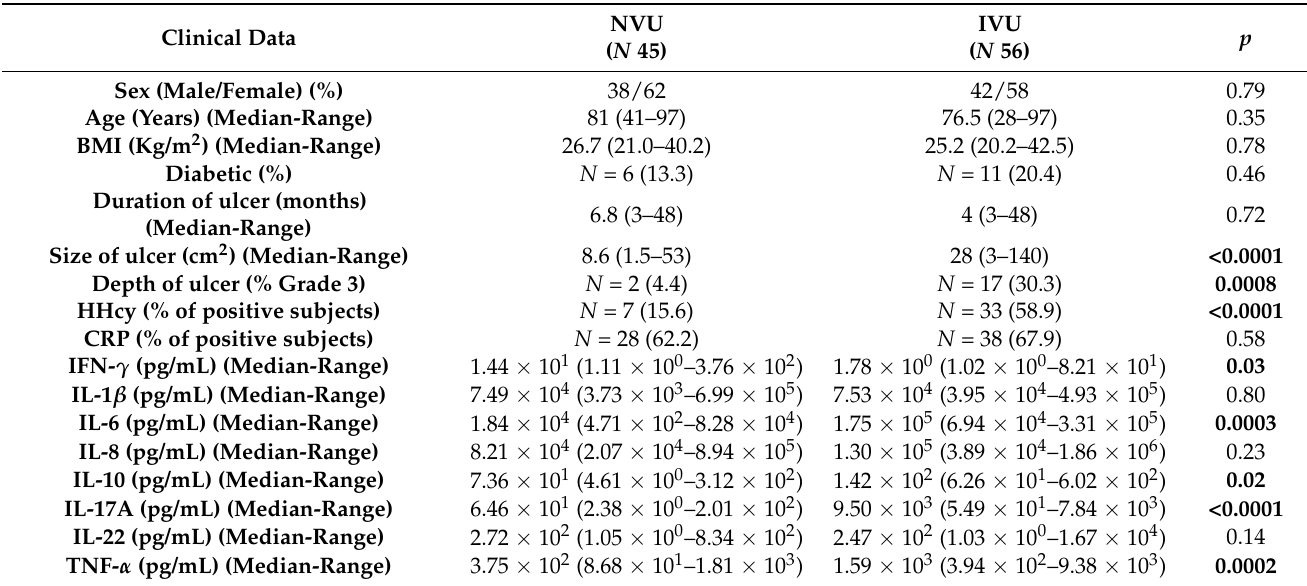
Table 1. Body mass index (BMI), hyperhomocysteinemia (HHcy) cut-off was set at >15.0 µ mol/L;